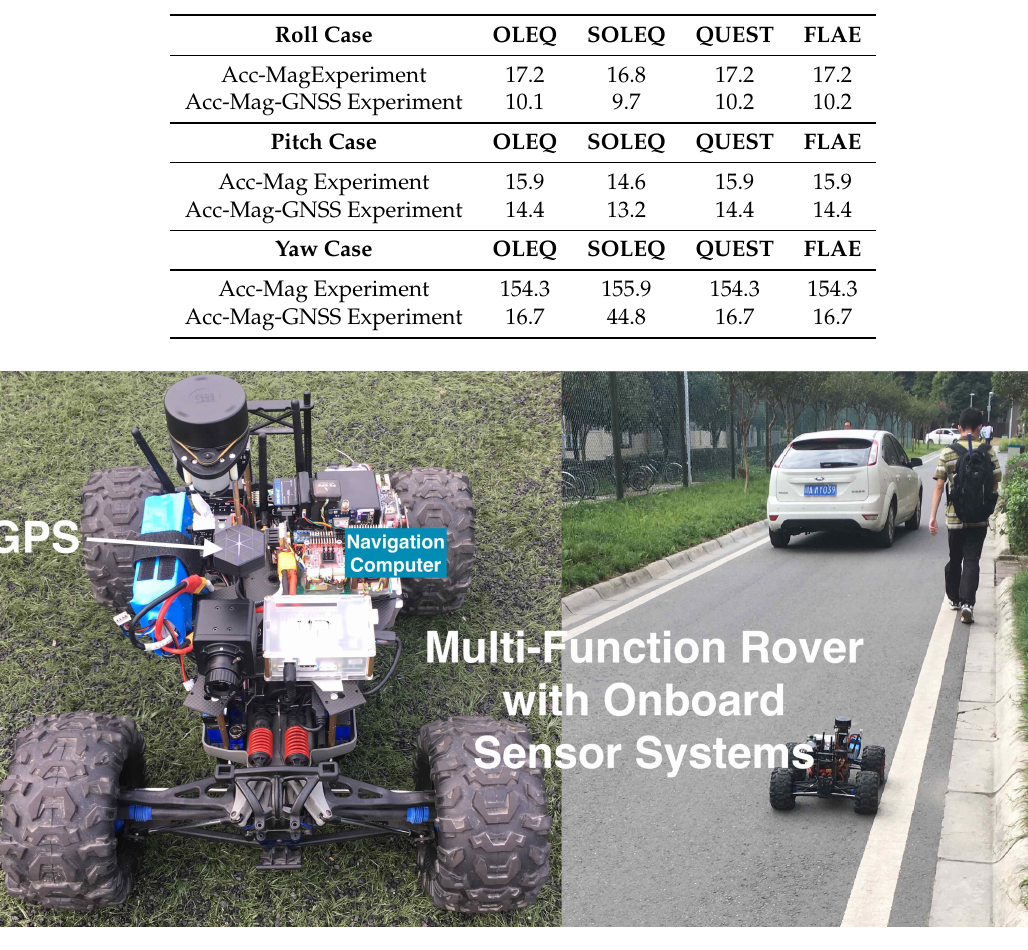
Figure 6. The designed multi-functional rover for the validation of the proposed